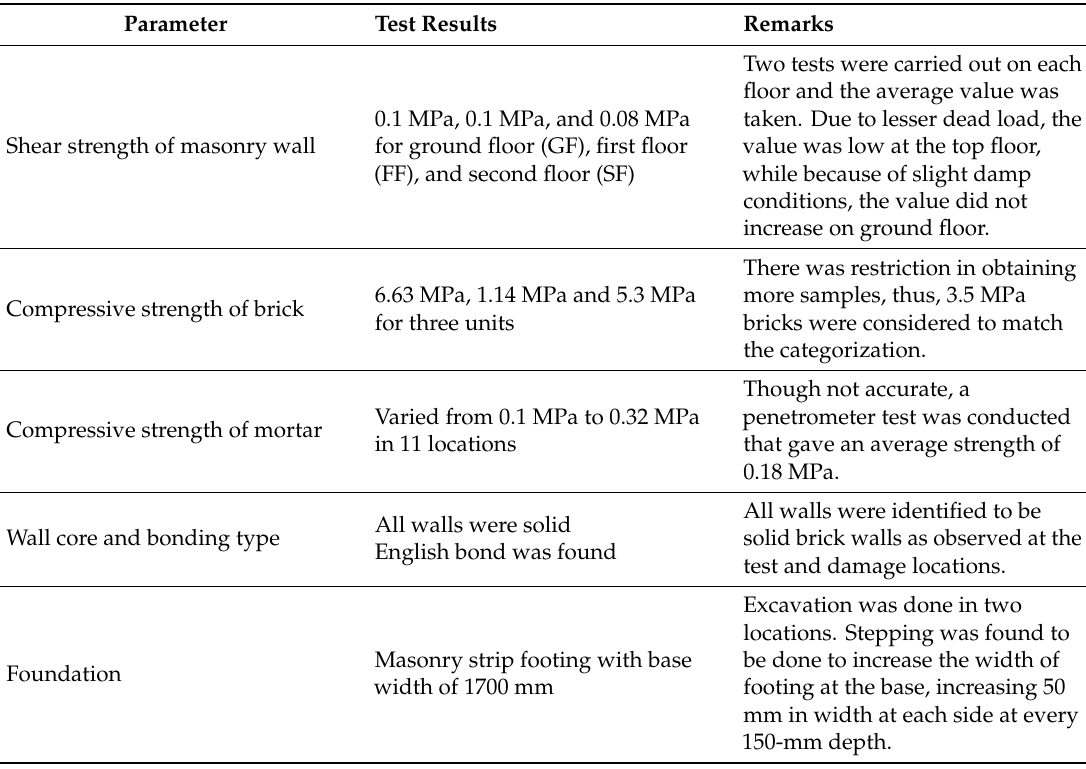
Table 1. Summary of material test